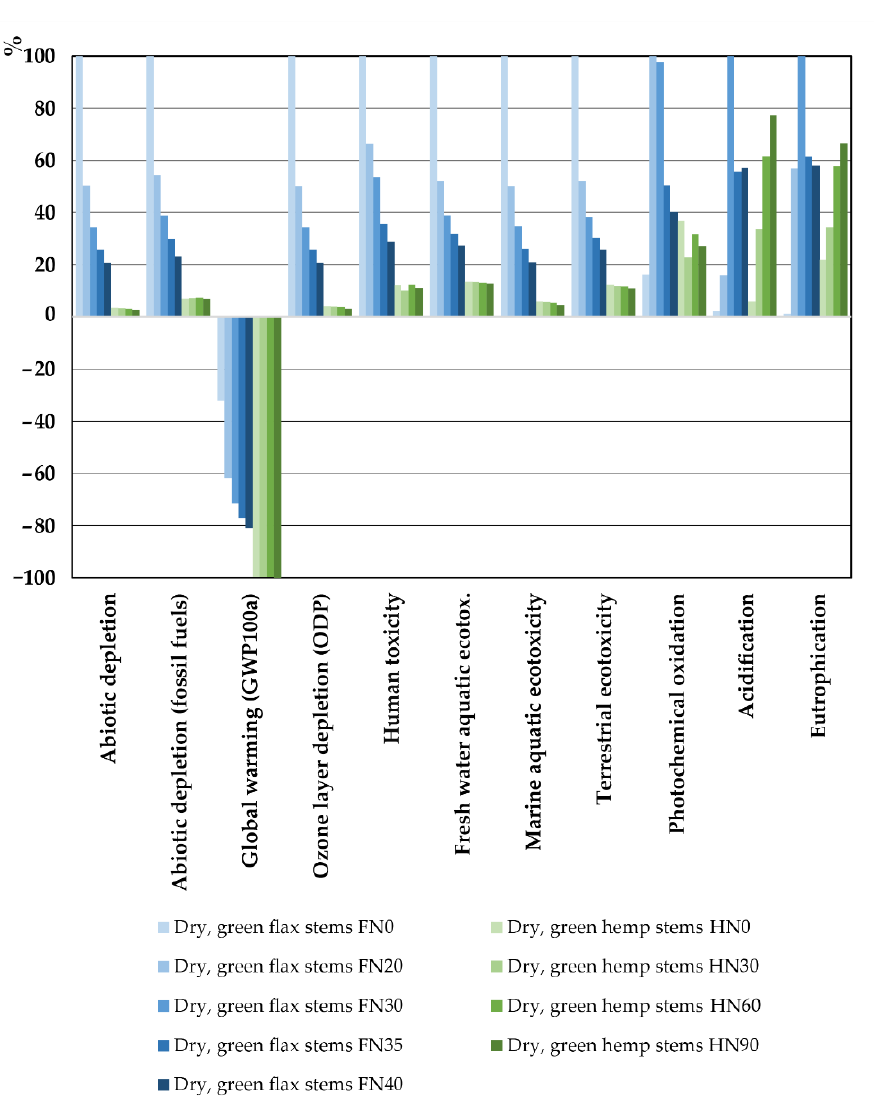
Figure 4. Environmental impact of flax and hemp cultivation depending on fertilization scenarios.